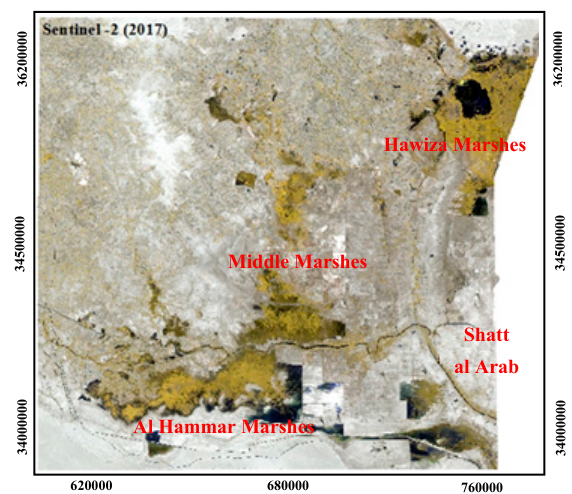
Figure 2. Images used in the current study.